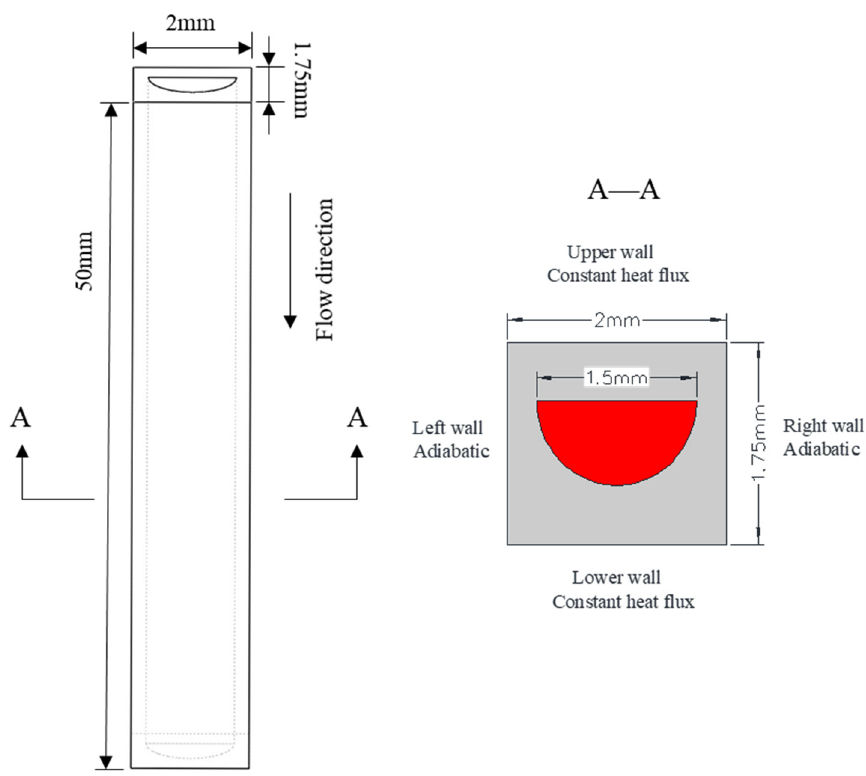
Figure 8. Numerical model and boundary conditions.